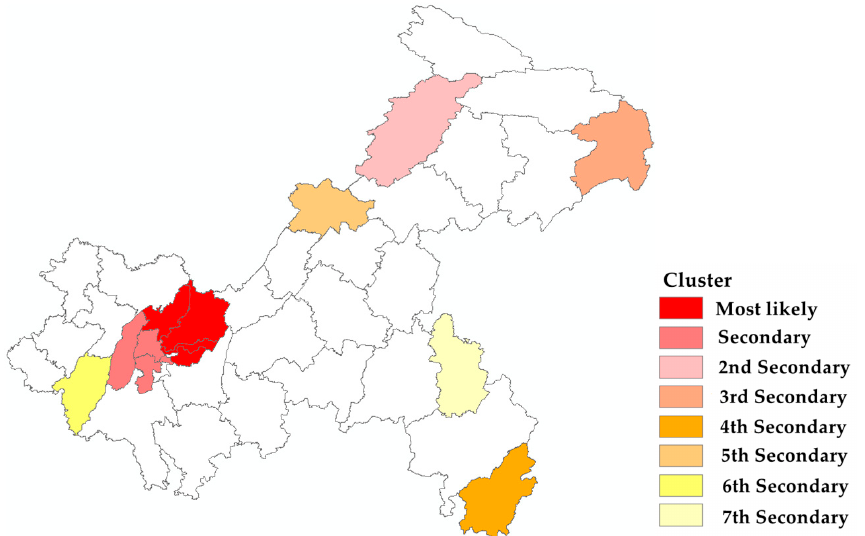
Figure 5. Spatial cluster map of varicella in Chongqing, 2014 to 2018.